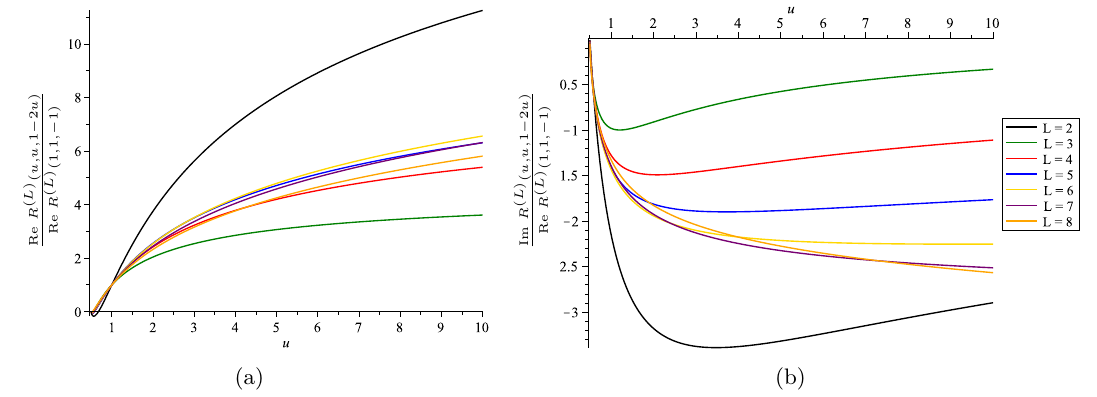
Figure 5. The real (a) and imaginary (b) parts of the remainder function R ( L ) on the u = v line in scattering region IIa, where u > 1 / 2 . We have normalized these functions by the value of their real part at u = 1